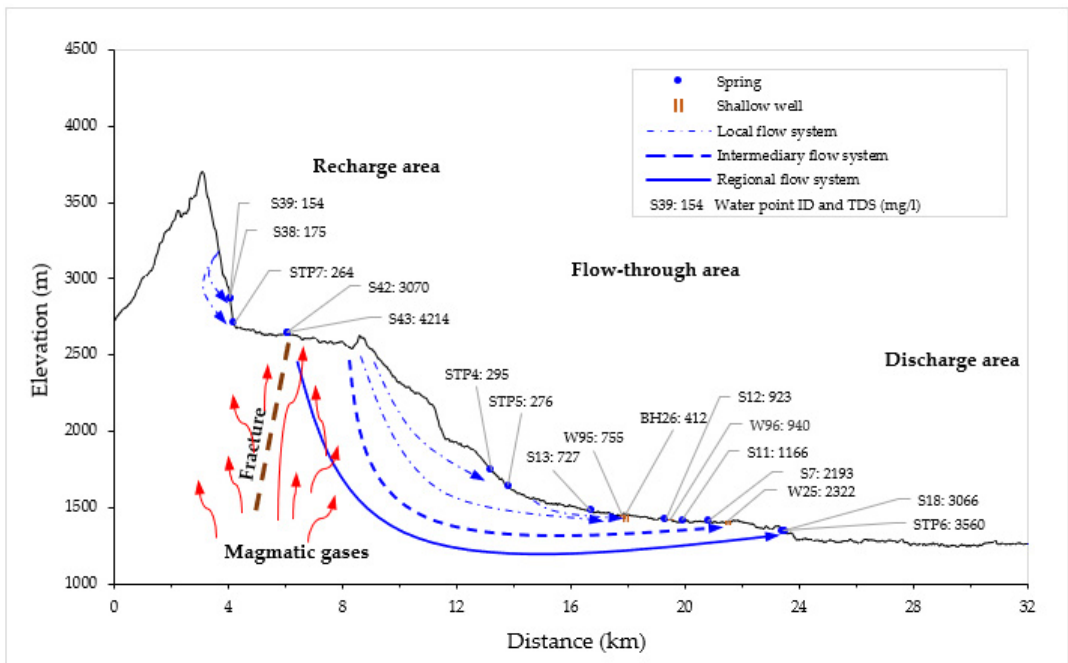
Figure 7. Simplified groundwater flow conceptual model for the northeastern flank of Mount Meru, suggesting the influence of the volcanic gases in the groundwater chemistry and also showing the increase of groundwater mineralisation with water residence times.